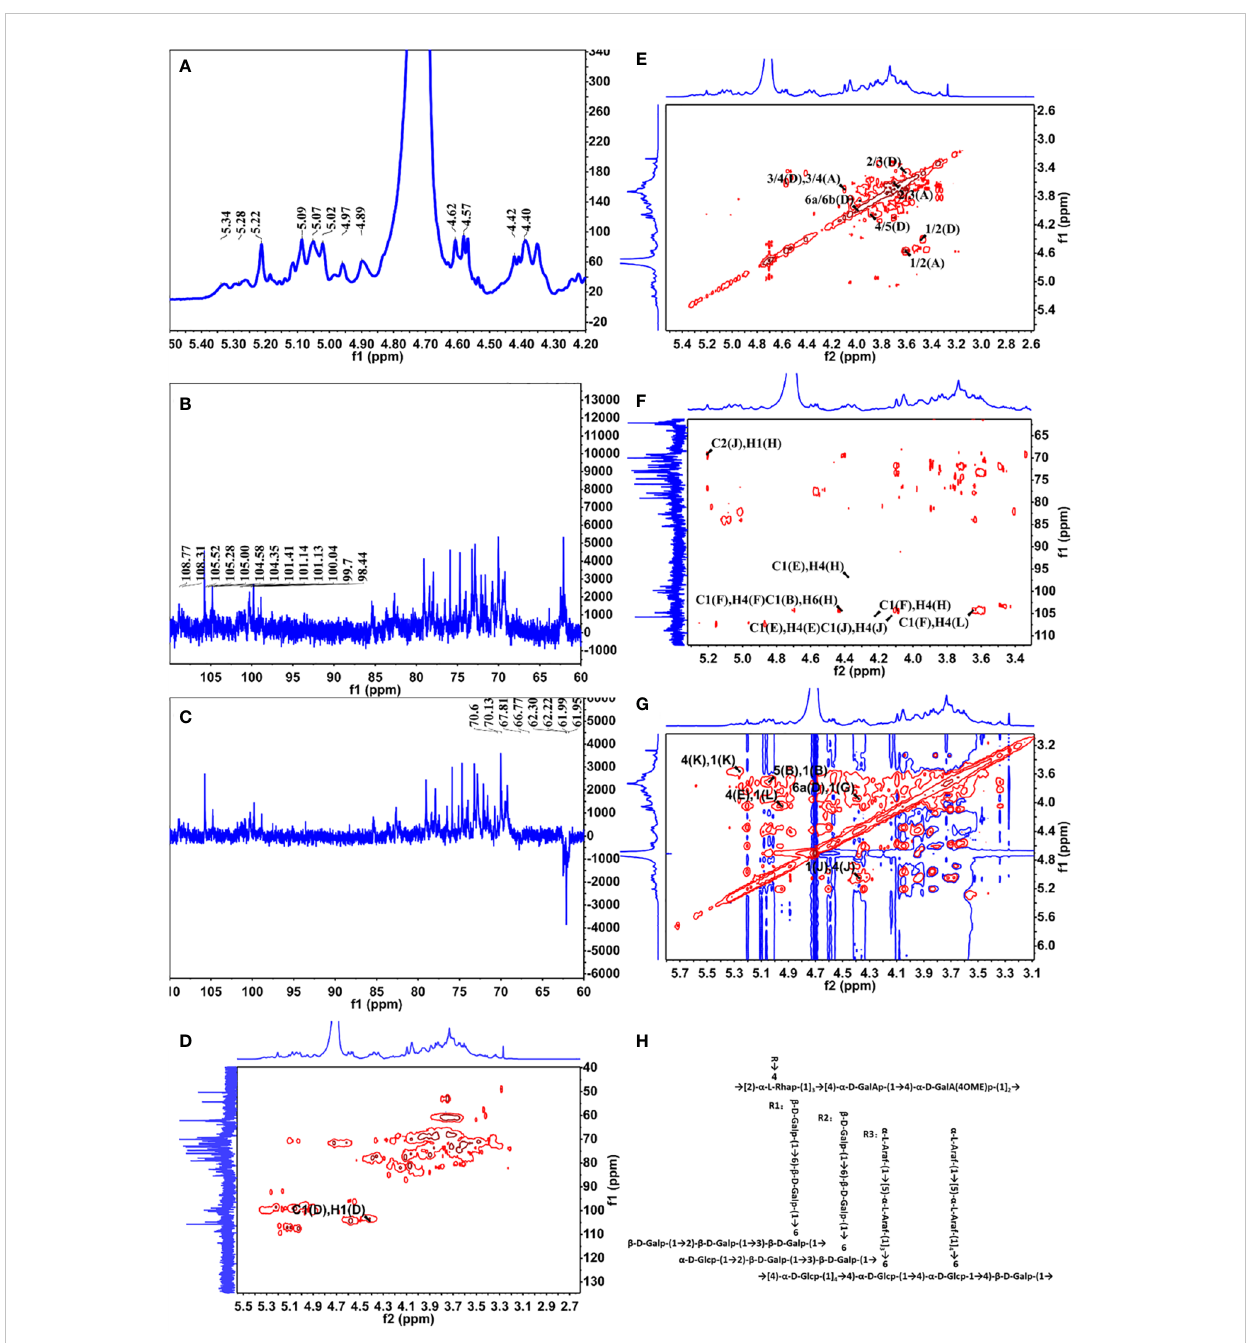
FIGURE 2 NMR spectra of YZ0.5-A. (A) 1 H NMR; (B) 13 C HMR; (C) DEPT 135; (D) HSQC; (E) COSY; (F) HMBC; and (G) NOESY. (H) Putative structure of